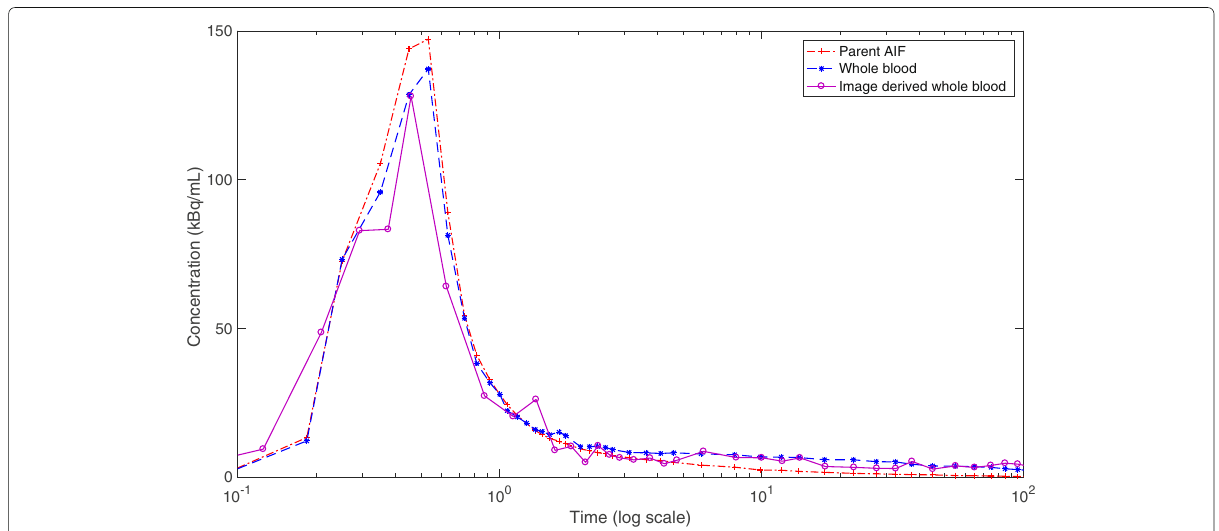
Fig. 2 Comparison of image-derived and arterial blood sample-derived whole blood curves for one subject plotted together with the metabolite-free parent AIF derived from blood samples. The x -axis is set to log scale to display curve peaks and tails clearly